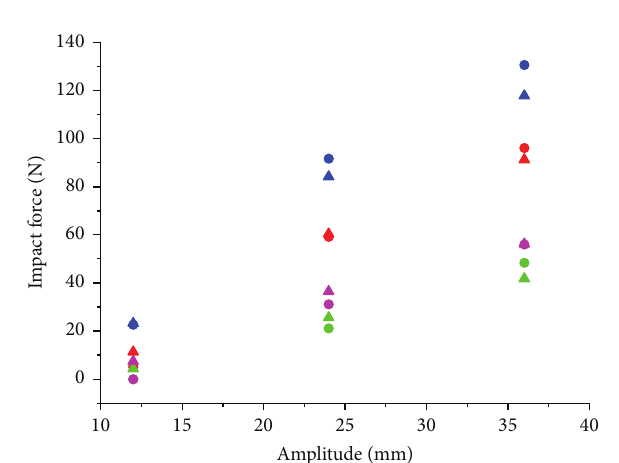
Figure 7: Schematic of area dividing.